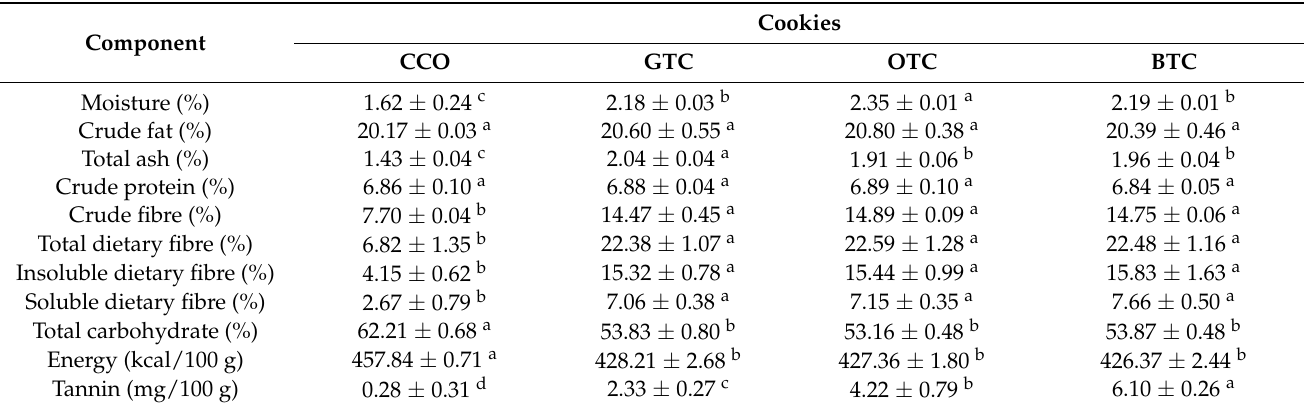
Table 2. Proximate composition, energy value, and tannin content of non-gluten shortbread cookies with various spent tea leaf